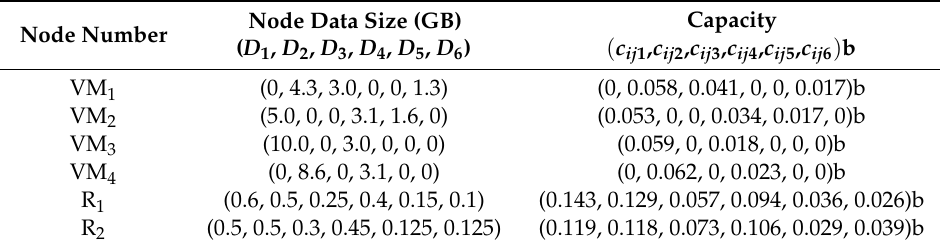
Table 2. Node configuration and data transmission capacity.